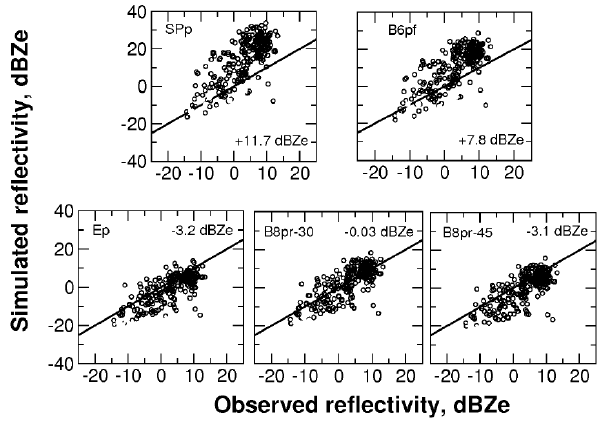
Figure 2. Comparisons of observed W-band reflectivities with syn- thetic reflectivities derived from the DDA scattering properties as taken from a modified figure from Wood et al.